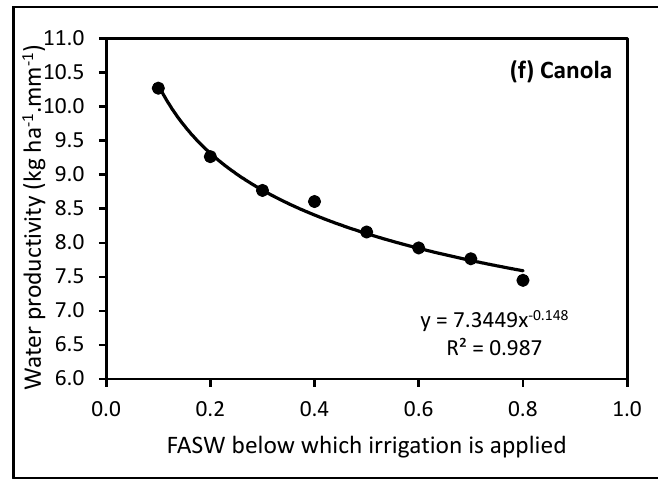
Figure 6. Water productivity of summer and winter crops at different soil water deficit levels in the Riverina region of NSW, Australia.